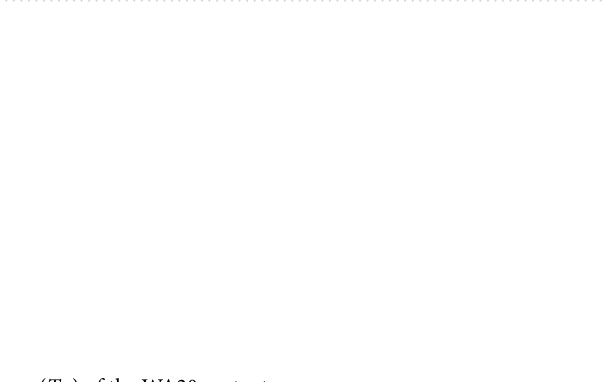
Table 1. Denaturation midpoint temperatures ( T m ) of the WA20